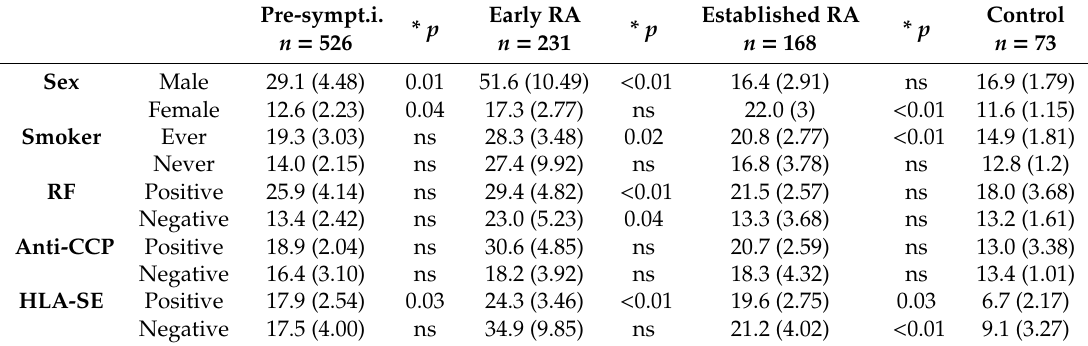
Table 3. Anti-LtxA IgM levels (AU / mL) according to demographic